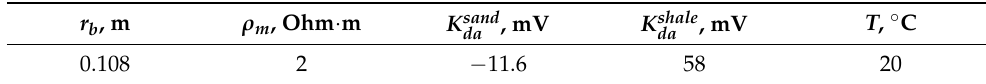
Table 1. Parameters of the sandstone bed model in the adjacent shale sediments used in the numerical